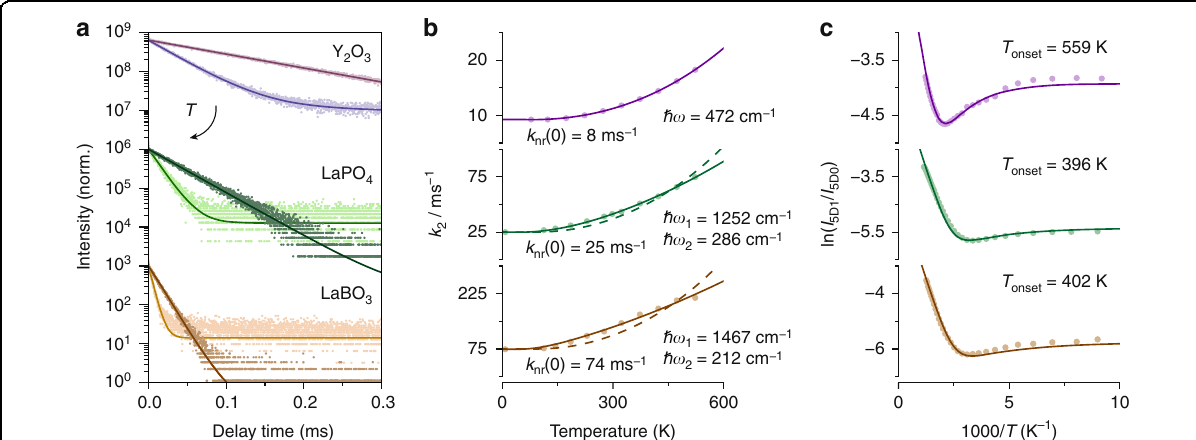
Fig. 2 Relation between the maximum phonon energy and the onset of thermal equilibrium. a Luminescence decay curves of the 5 D 1 emission for Y 2 O 3 (top), LaPO 4 (middle), and LaBO 3 (bottom). The luminescence was excited at 7 F 0 → 5 D 1 and the decay curves were measured at 78 K (dark color, slower decay) and 523 K (light color, faster decay). b Decay rates of the 5 D 1 emission at various temperatures. The solid line in the top plot and the dashed lines in the middle and bottom plots are fi ts of the experimental rates (dots) to Eq. 1, while the solid lines in the middle and bottom plots are fi ts to Eq. 3. c Intensity ratios of the 5 D 1 and 5 D 0 emissions for various temperatures determined from luminescence spectra upon excitation into the charge-transfer states. The solid lines are fi ts of the experimental ratios (dots) to the model of Eq. 4 for Y 2 O 3 and Eq. 5 for LaBO 3 and LaPO 4 (lines). The onset temperatures for thermal equilibrium ( T onset ) were calculated using Eq. 6 for Y 2 O 3 :Eu 3 + and a numerical solution was used for LaPO 4 :Eu 3 + and LaBO 3 :Eu 3 + (see text for further